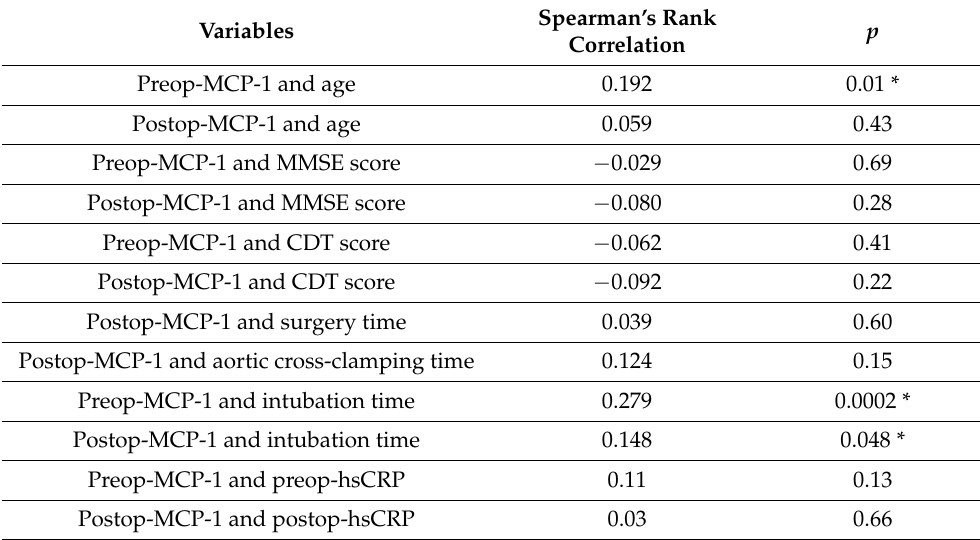
Table 5. The correlations between pre- and postoperative MCP-1 levels and demographic, psychiatric and perioperative